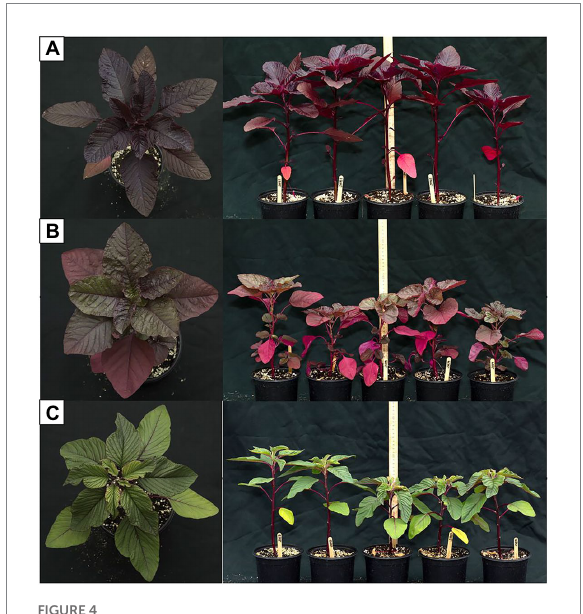
FIGURE 4 Aerial and profile photographs of (A) A. cruentus ‘Hopi Red Dye’ (Seeds of Change), (B) A. tricolor PI 277269, and (C) A. quitensis PI 490710 as examples of variation in morphology and